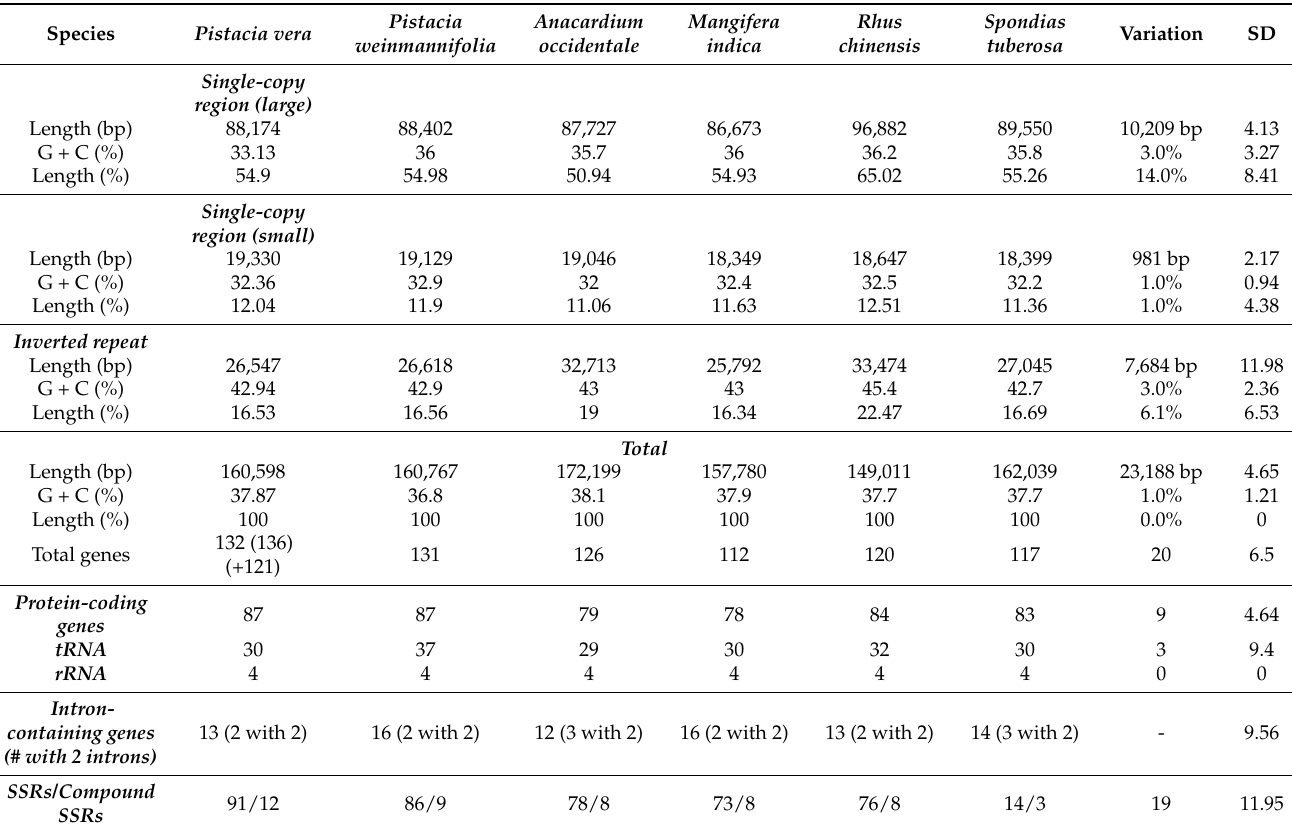
Table 6. Sequence comparison of the P. vera chloroplast genome sequence with other Anacardiaceae family